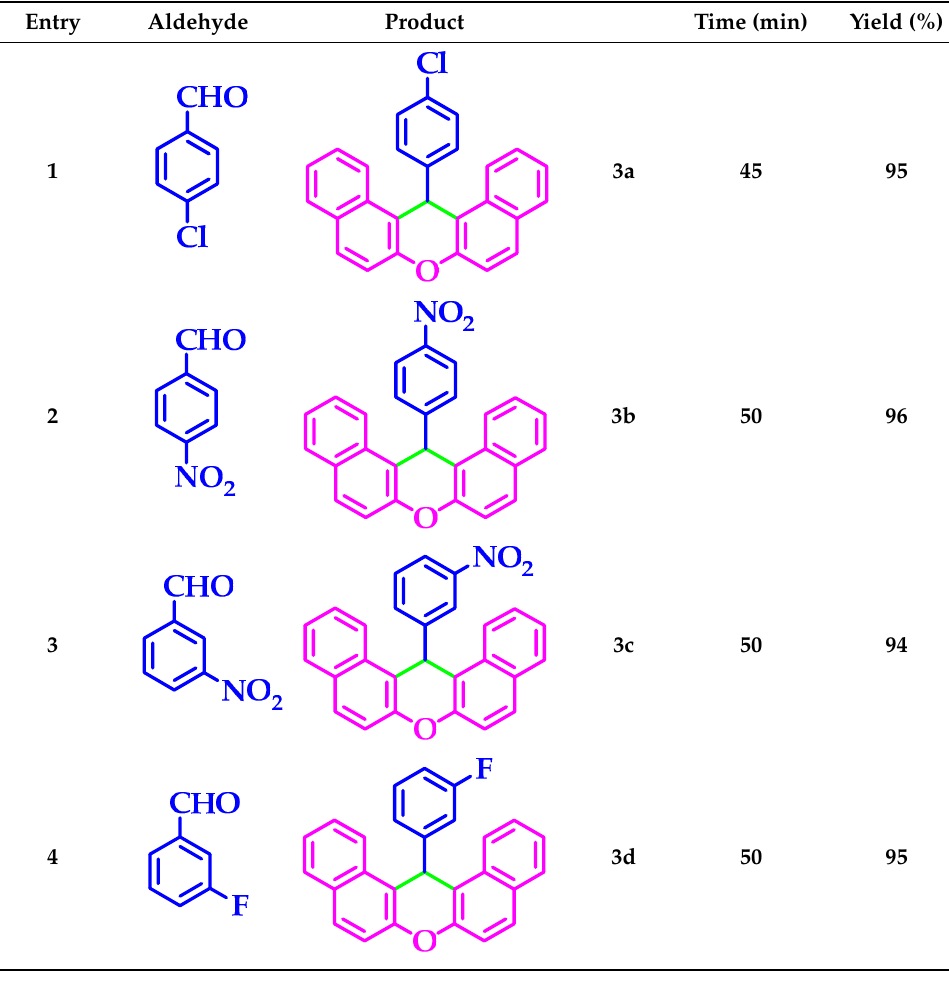
Table 3. Synthesis of 14-substituted-14-H-dibenzo[ a,j